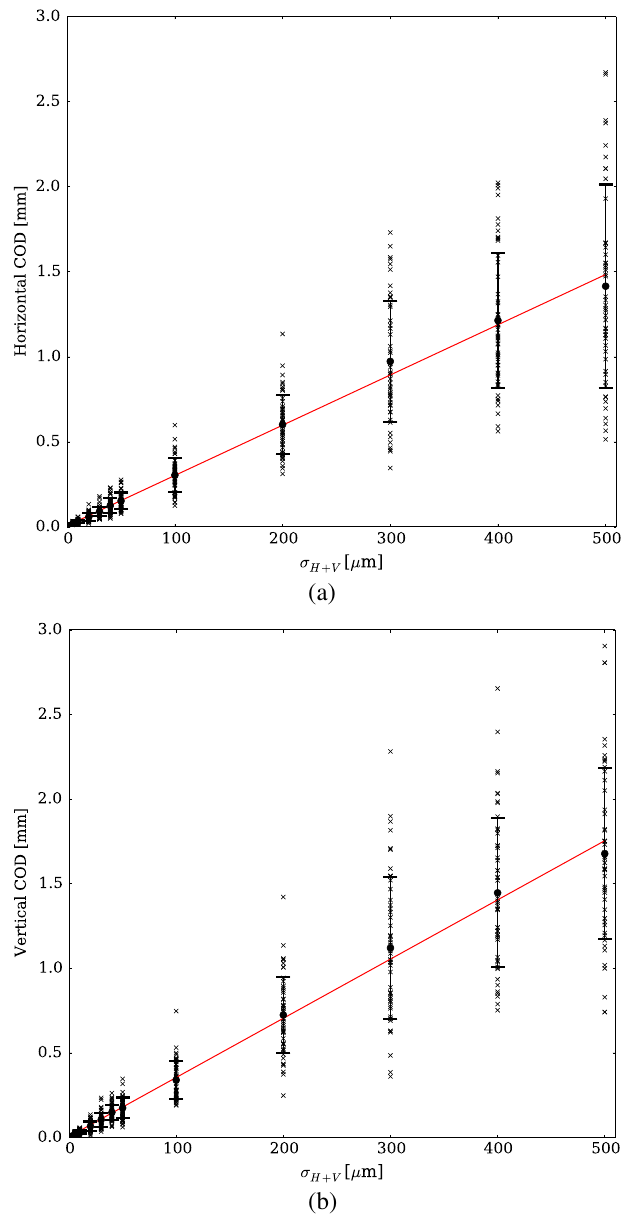
FIG. 10. The horizontal (a) and vertical (b) rms COD with cell misalignment errors. Each individual randomly offset lattice is shown as a cross, the mean is shown as a filled circle, and the standard deviation as the error bars. The red line shows a minimum chi-squared fit to the